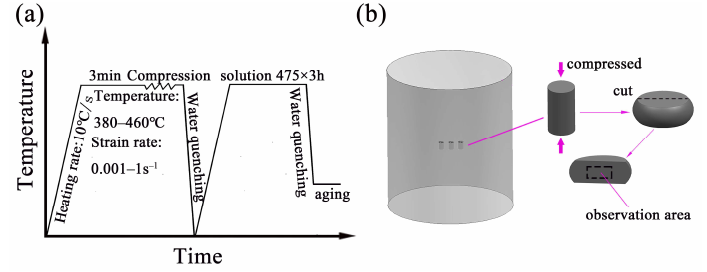
Figure 1. ( a ) Processing diagram, ( b ) Sampling scheme.